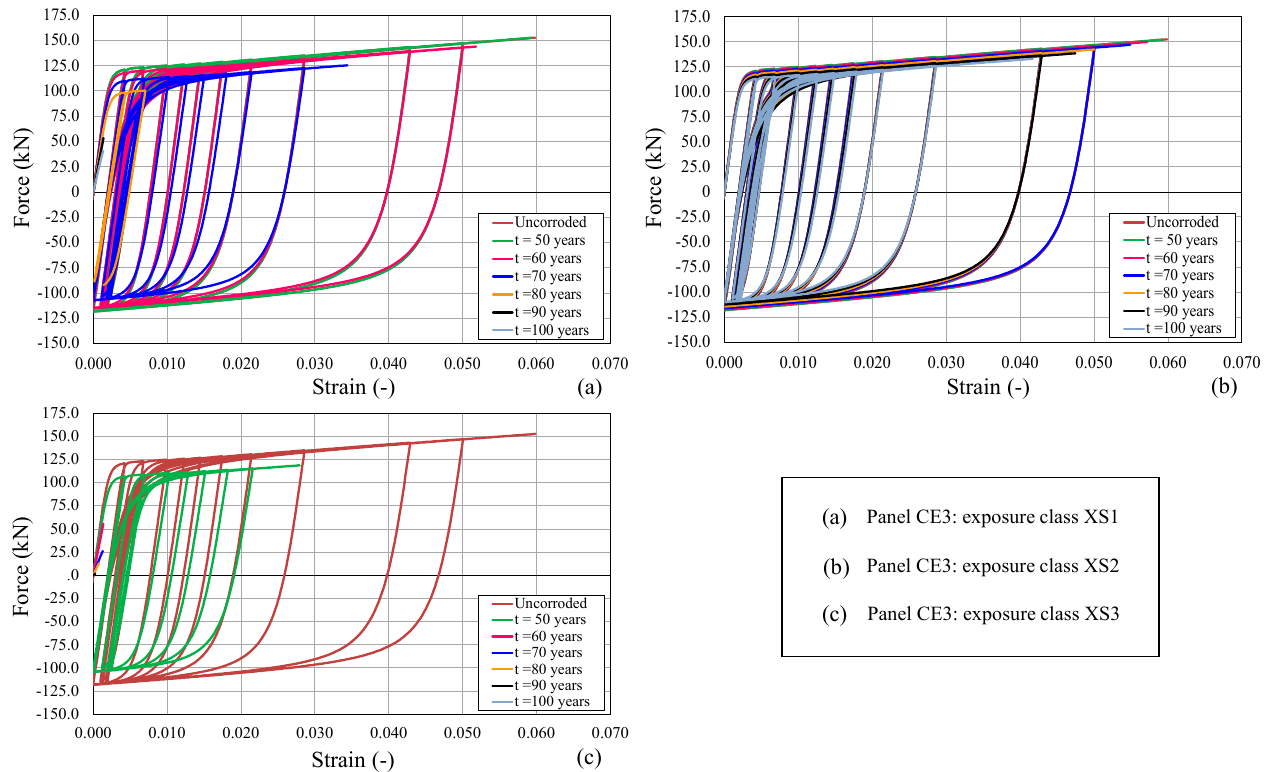
Figure 5. Force–strain curves over time of panel CE3 for the exposure class: ( a ) XS1, ( b ) XS2, and ( c ) XS3.